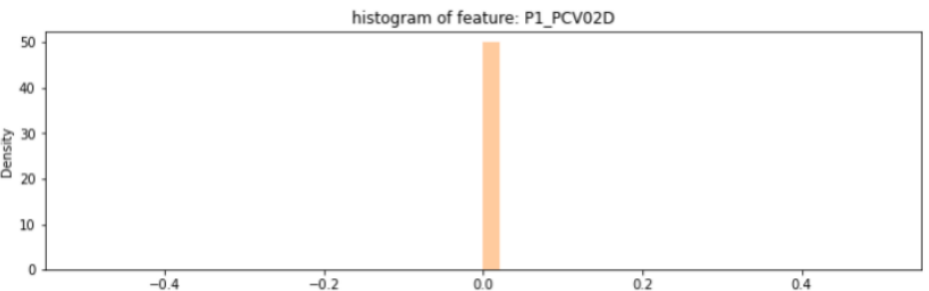
Figure 8. Feature graph for data point P1_PCV02D. This feature graph means that the values of the data points do not change over time.